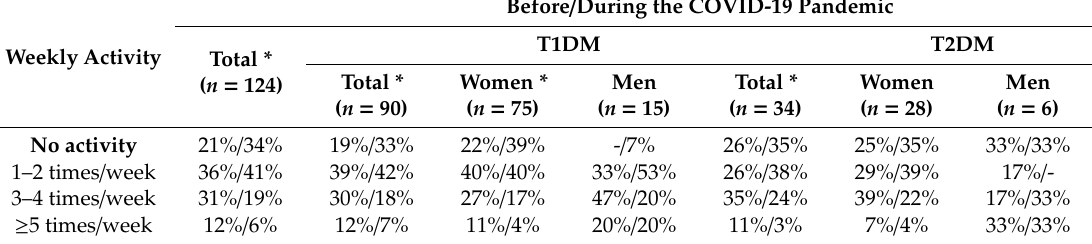
Table 2. Characteristics of the subgroups, frequency of physical activity before and during the COVID-19